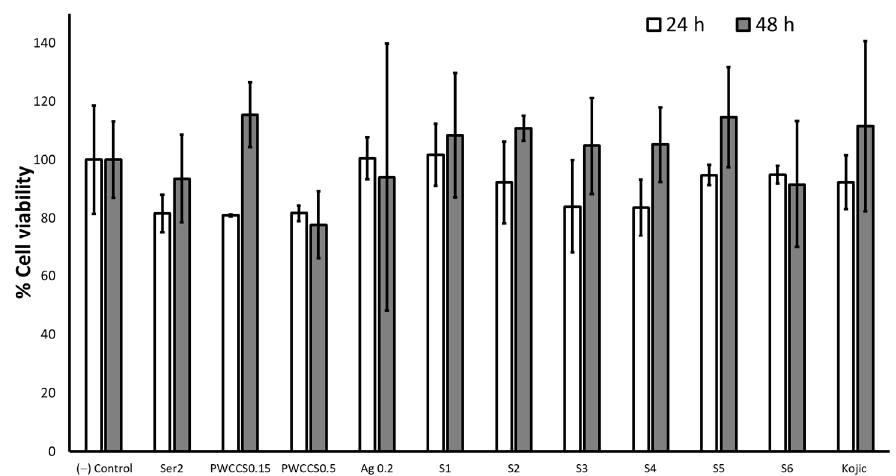
Figure 5. Effect of 2% sericin (Ser2), 0.15% PWCCS (PWCCS0.15), 0.5% PWCCS (PWCCS0.5), 0.2% alginate (Ag0.2), 100 µ g/mL kojic acid (Kojic), and the hydrogels S1–S6 on the cell viability of the B16F10 cells after 24 and 48 h. Data represent the mean ± SEM of the three replicates.